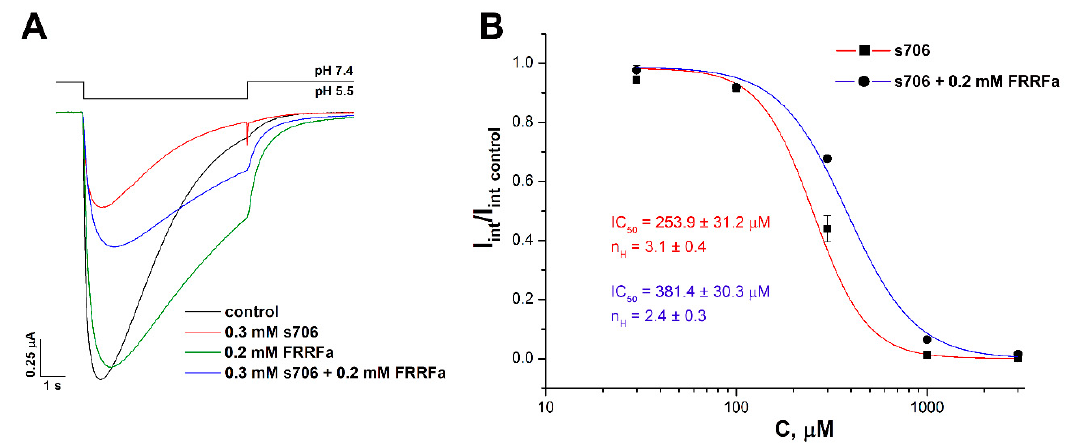
Figure 3. Comparison of sevanol ( s706 ) and the Phe-Arg-Arg-Phe-amide peptide (FRRFa) effects on the ASIC1a current. ( A ) Representative traces of pH 5.5-evoked currents of ASIC1a alone (black trace) and of ASIC1a with a 15 s pre-incubation of 300 µM s706 (red trace), 200 µM FRRFa (green trace), or a mixture of 300 µM s706 and 200 µM FRRFa (blue trace). ( B ) Dose–response ASIC1a inhibitory curves for s706 alone (red line) and for s706 in the presence of 200 µM FRRFa (blue line), determined for integral currents. Data were fitted by the logistic equation. Data are presented as mean ± SEM ( n = 5).